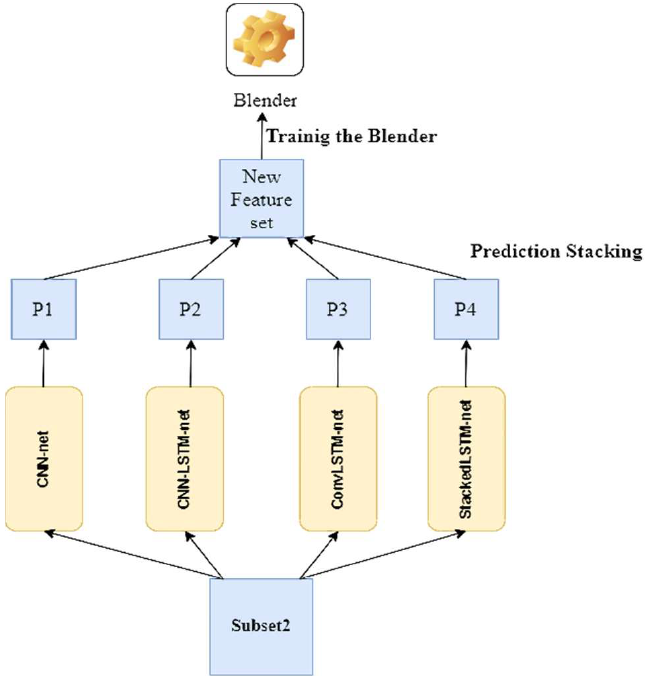
Figure 8. Training the blender.